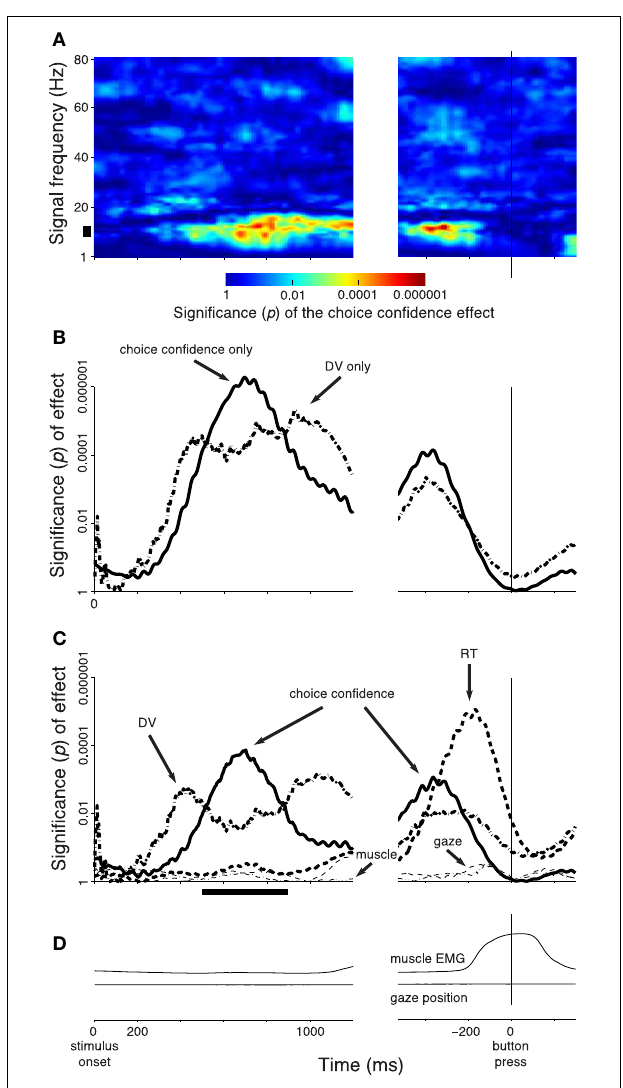
FIGURE 3 | Subjects’ confidence in a button press choice reflected in cortical signals. In all panels, effects are shown as a function of time throughout the trial. Data are aligned on the stimulus onset (left), and on the time of the button press (right). The figure shows effects during all button press choices. (A) The significance of the weight ( p -value associated with the t -statistic, see color bar) of the choice confidence regressed on the neural activity (i.e., the contrast between sure and unsure trials), at each time throughout the trial and at each frequency in the range from 1 to 80Hz. The thick vertical bar spanning the range 8–12Hz denotes the alpha band. (B) The significance of the weight ( p -value associated with the t -statistic) of the choice confidence (solid) or the DV (dash-dot), separately regressed on the neural signals measured in the alpha band, as a function of time. (C) The significance of weight of individual factors in a multiple regression on the neural signals measured in the alpha band, as a function of time. The factors include the choice confidence, the DV, the reaction time (RT), the horizontal eye position, and the EMG activity of the forehand muscle flexor carpi radialis. The solid bar below the abscissa denotes the period of significance of the choice confidence effect during the stimulus period. (D) The mean activity of the forehand muscle flexor carpi radialis and the mean horizontal eye gaze position. In all panels, signal power was computed in 300ms sliding windows (30ms overlap) and averaged over all channels. The behavioral traces in (D) were computed as means over the corresponding 300ms